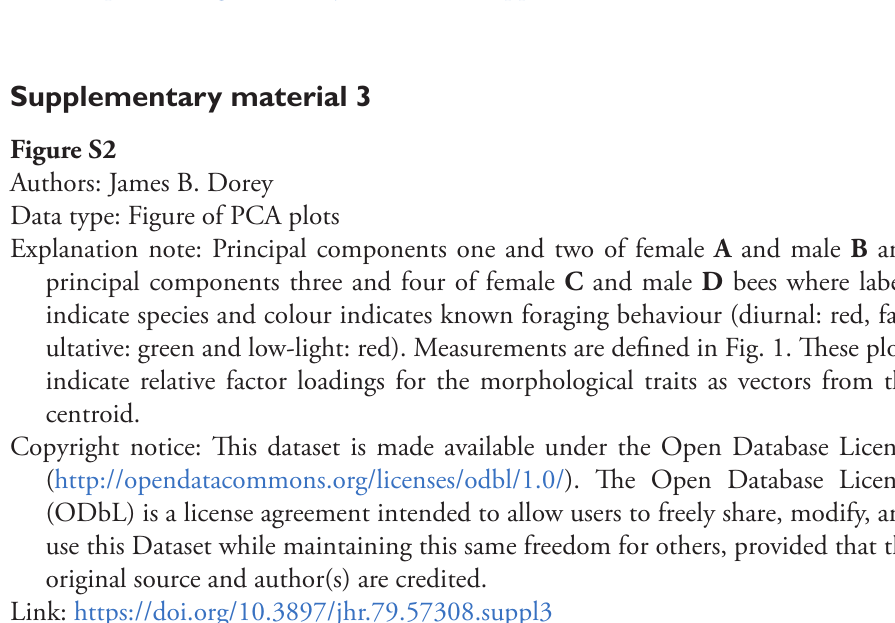
Data type: Scree plots and heat maps of factor loadings from PCA analyses Explanation note: Scree plots of principal components (proportion of variance; top) and heatmaps and values of the loadings of measurements on each principal com- ponent (bottom) for females A and males B .